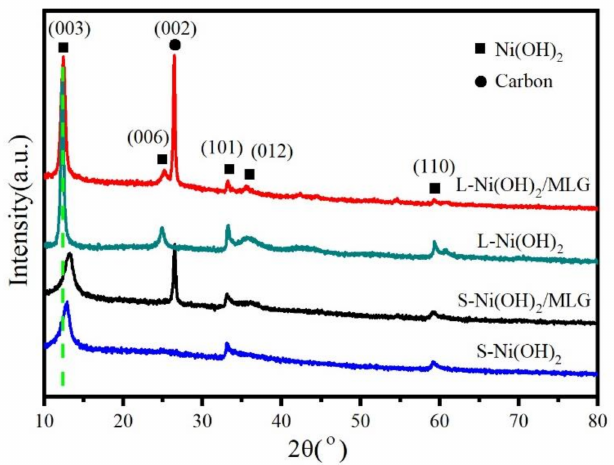
Figure 1. X-ray diffraction (XRD) patterns of samples S-Ni(OH) 2 /MLG, L-Ni(OH) 2 /MLG, S-Ni(OH) 2 and L-Ni(OH) 2